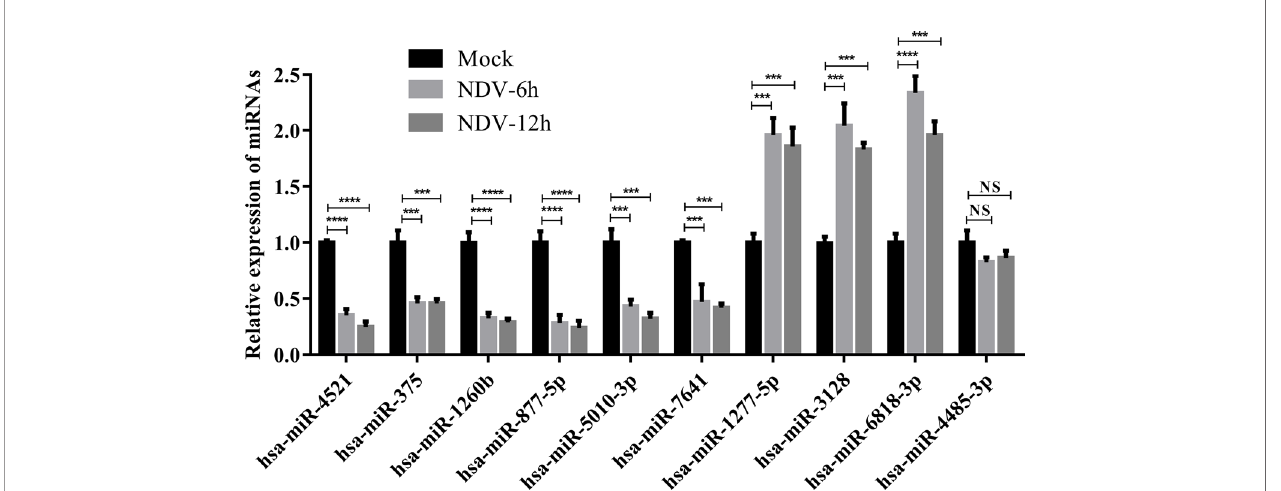
FIGURE 6 | Veri fi cation for the expression patterns of 10 selected SDE miRNAs by qRT-PCR. HeLa cells were infected with Herts/33 at an MOI of 1. Total miRNAs in HeLa cells were extracted at 0, 6 and 12 hpi, respectively. Expression levels of 10 selected SDE miRNAs were measured by qRT-PCR. The relative expression level of each miRNA in the NDV-infected HeLa cells was calculated using the 2 - DD CT method and represented as the n-fold change relative to the mock-infected sample. Bar diagrams show the means ± SD obtained from triplicate experiments. *** stands for P -value < 0.001, **** stands for P -value < 0.0001 and NS stands for non signi fi